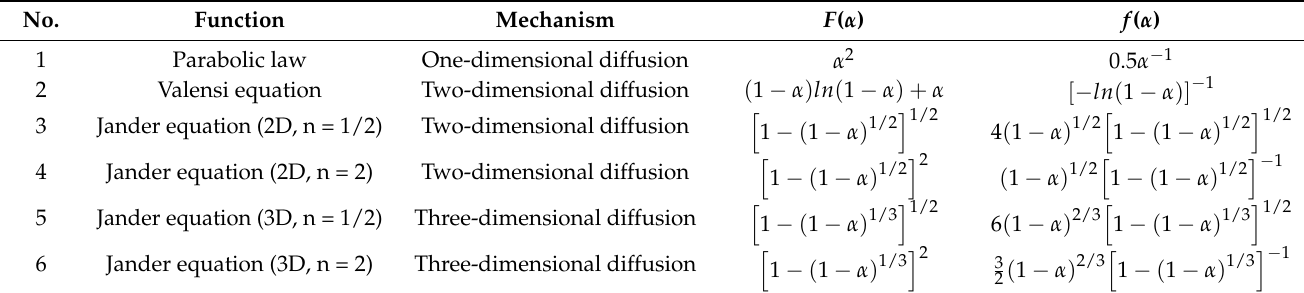
Table 3. Model function F ( α ) and f ( α ) for normal solid-state